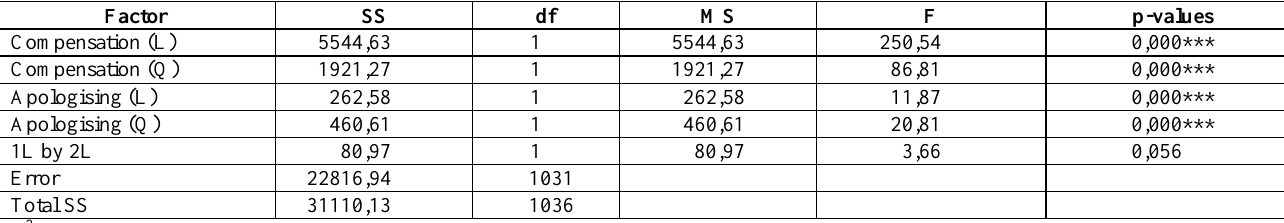
Table 8: ANOVA results: Study 2, restaurants